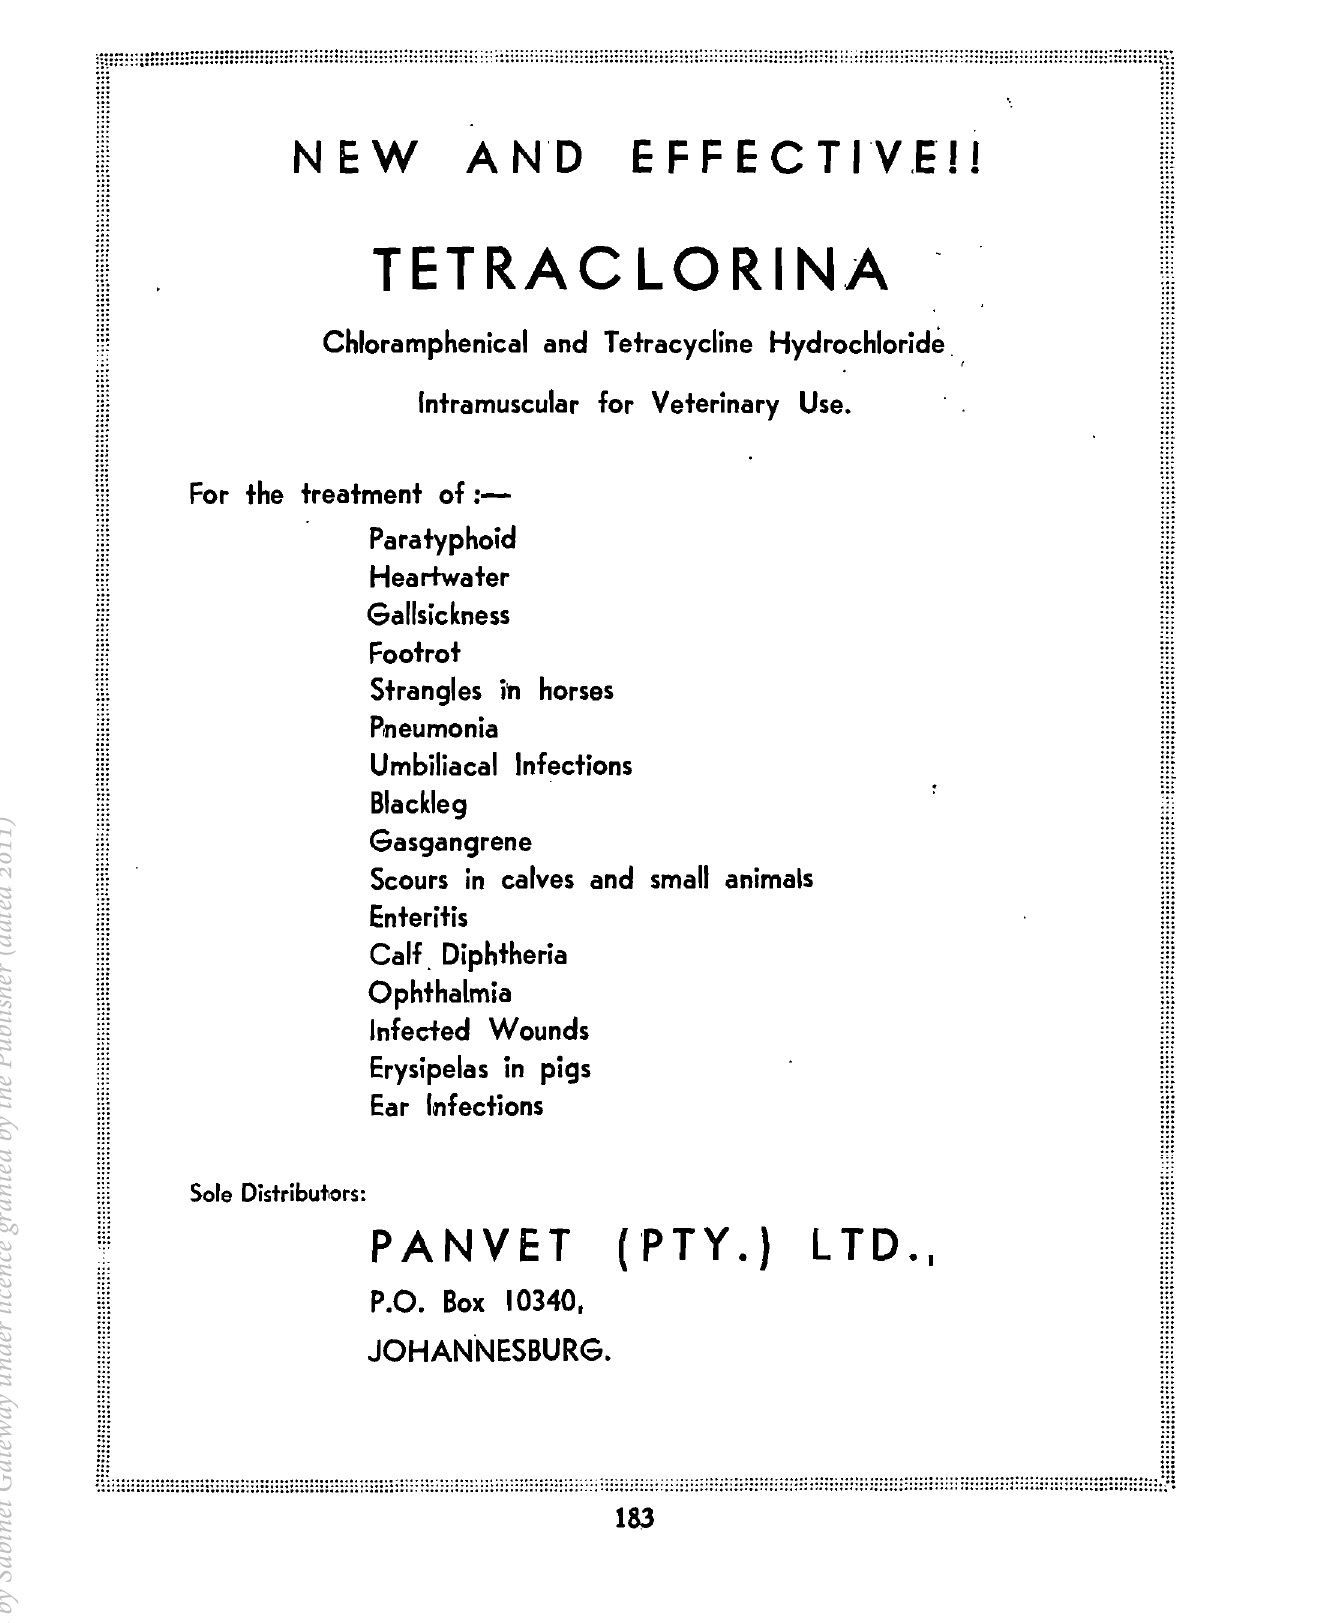
Sole Distribut,ors: PANVET P.O. Box 10340,